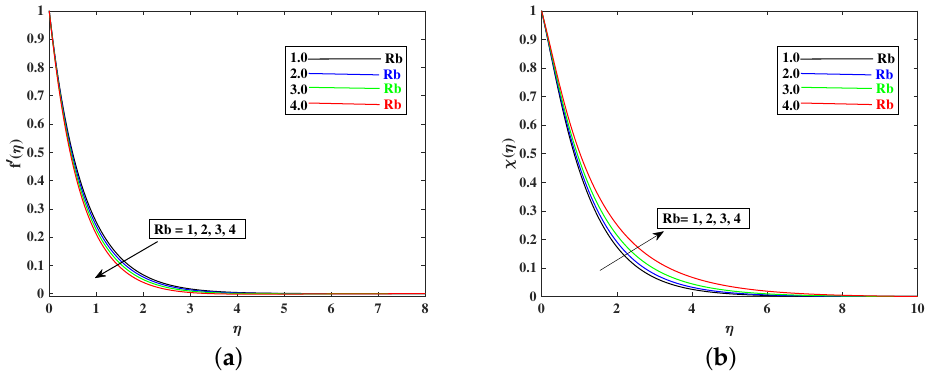
Figure 6. Variation of Rb to influence the velocity and bioconvection profile. ( a ) Variation of Rb to influence the velocity. ( b ) Variation of Rb to influence the bioconvection